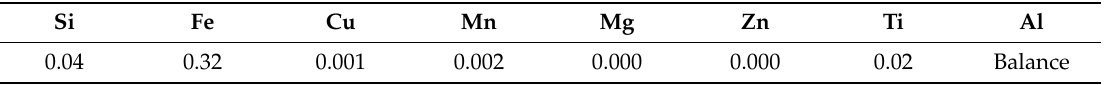
Table 1. Chemical composition of AA1050-H14 (in wt.